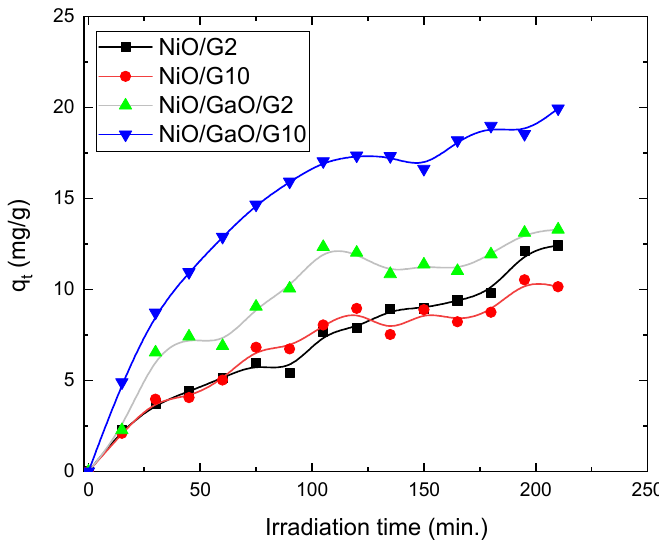
Figure 9. Effect of the contact time on the degradation capacity of CR on NiO/G2, NiO/G10, NiO/Ga 2 O 2 /G2, and NiO/Ga 2 O 2 /G10 nanocomposites.